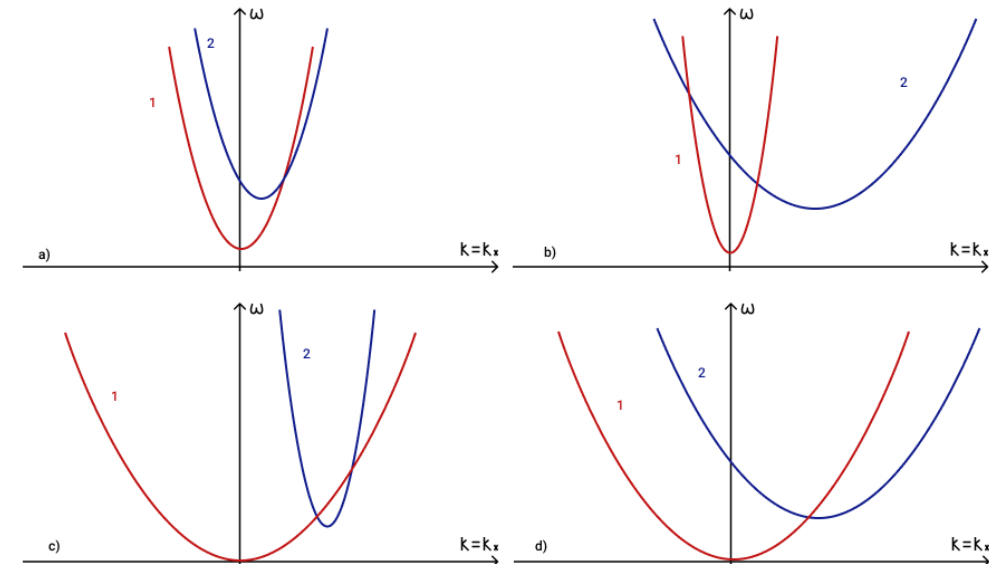
Figure 24. Phase matching conditions for waves in a horizontal magnetic field, namely for ( a ) three magneto-Poincare waves: 1— ω = ω mP ( k x ) , 2— ω = ω mP ( k x − k x Poincare and one magnetostrophic waves: 1— ω = ω mP ( k x ) , 2— ω = ω ms ( k x − k x ( c ) two magnetostrophic and one magneto-Poincare waves: 1— ω = ω ms ( k x ) , 2— ω = ω mP ( k x − ) + ω ms ( k x ) , ( d ) three magnetostrophic waves: 1— ω = ω ms ( k x ) , 2— ω = ω ms ( k x − k x k x c c ) ω ms ( k x c